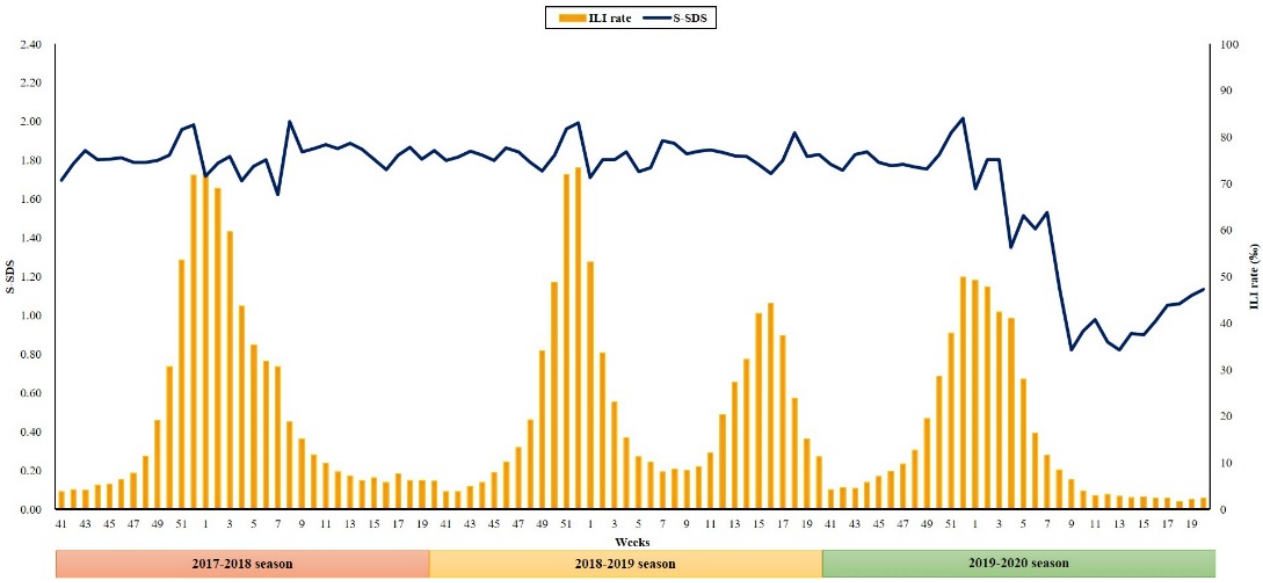
Figure 2. Weekly trend of ILI rates and S-SDS. The weekly trend of ILI rates and S-SDS during three consecutive flu seasons is shown as a line graph. ILI, influenza-like illness; S-SDS, subway use-based social distancing score.